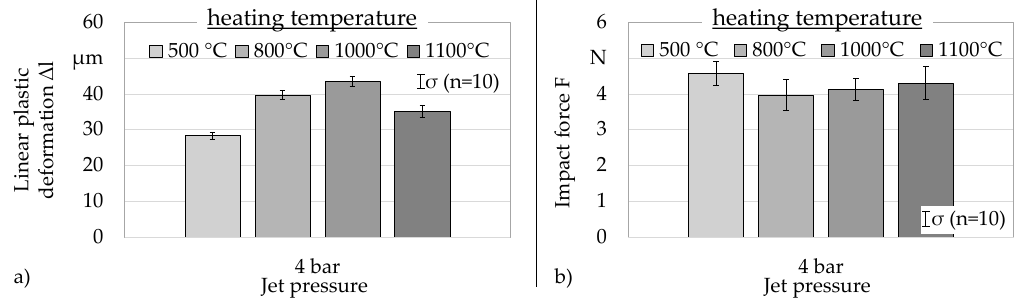
Figure 5. Descriptor values obtained after particle-oriented peening of DSC-treated particles ( a ) linear plastic deformation, ( b ) approximated impact force.